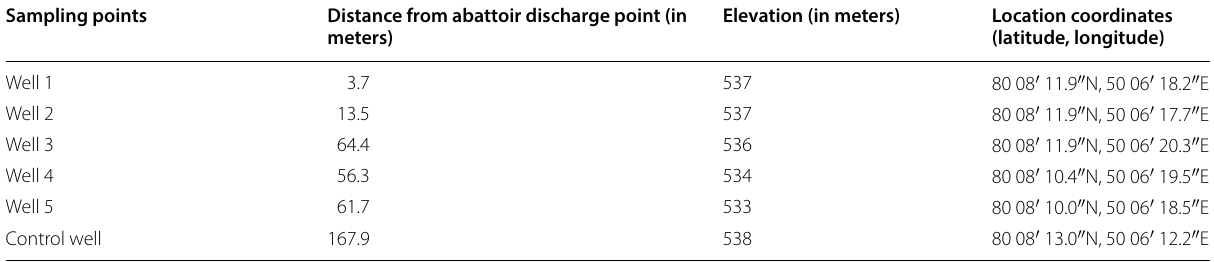
Table 1 Distance of sampling points from the abattoir with elevation and its coordinates Sampling points Distance from abattoir discharge point (in Elevation (in meters)